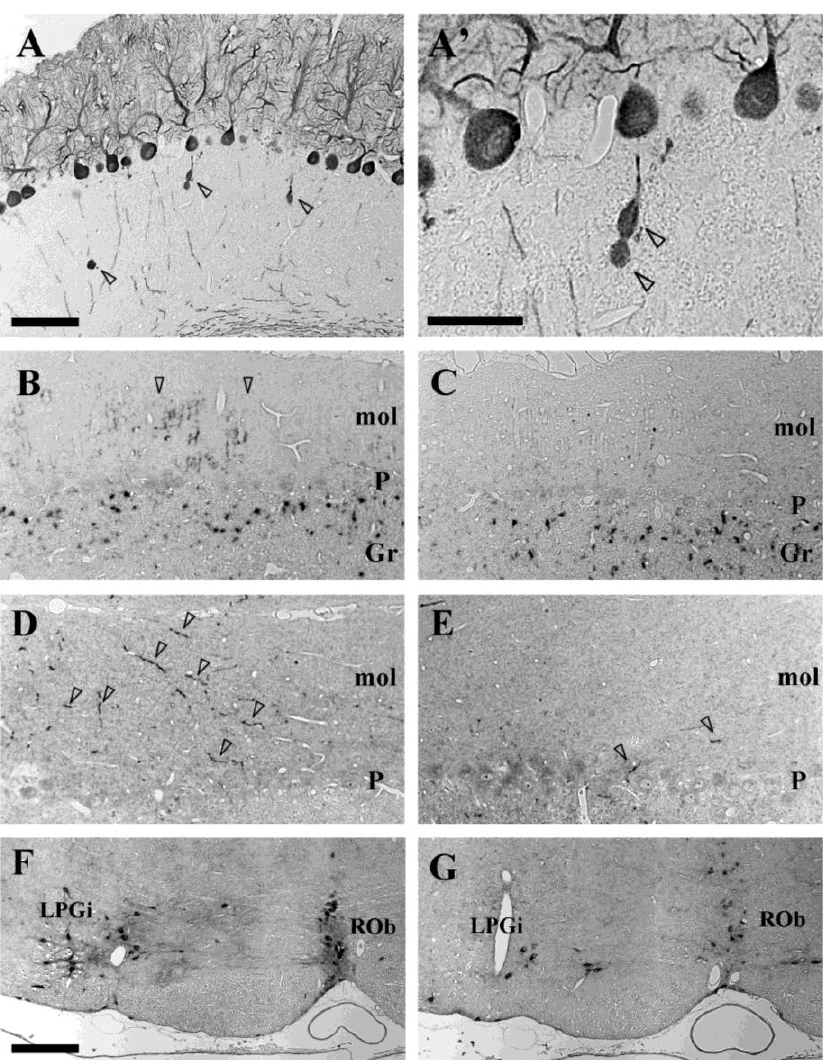
FIGURE 1. Cerebellar abnormalities of rolling mouse Nagoya. Calbindin D-28k immunostaining in the cerebellum of rolling mouse at low (A) and high (A’) magnifications. Arrowheads indicate abnormal swellings (torpedoes) of Purkinje cell axons. Immunostaining for corticotropin-releasing factor (CRF) in the cerebellum of rolling (B) and control mice (C). Arrowheads in (B) indicate the borders of CRF-immunopositive climbing fiber stripe. The staining intensity is enhanced in the rolling cerebellum, whereas the characteristic stripe pattern of CRF is sustained between rolling and control mice. Serotonin (5-HT) immunostaining in the cerebellar cortex of the vermis (D, E) and the origins of cerebellar 5-HTergic fibers (F, G). 5-HT–immunopositive fibers were densely present in the vermis of a rolling mouse (D), but not a control mouse (E). Arrowheads in (D) and (E) indicate 5-HT–immunopositive fibers. 5-HT immunostaining in the lateral paragigantocellular reticular nucleus of medulla oblongata was also more intense in a rolling mouse (F) than in a control mouse (G). LPGi, lateral paragigantocellular reticular nucleus; mol, molecular layer; P, Purkinje cell layer; ROb, raphe obscurus. Bar = 50 μm in (A)[applied to (B), (C), (D), and (E)], Bar = 20 μm in (A’), Bar = 100 μm in (F)[applied to